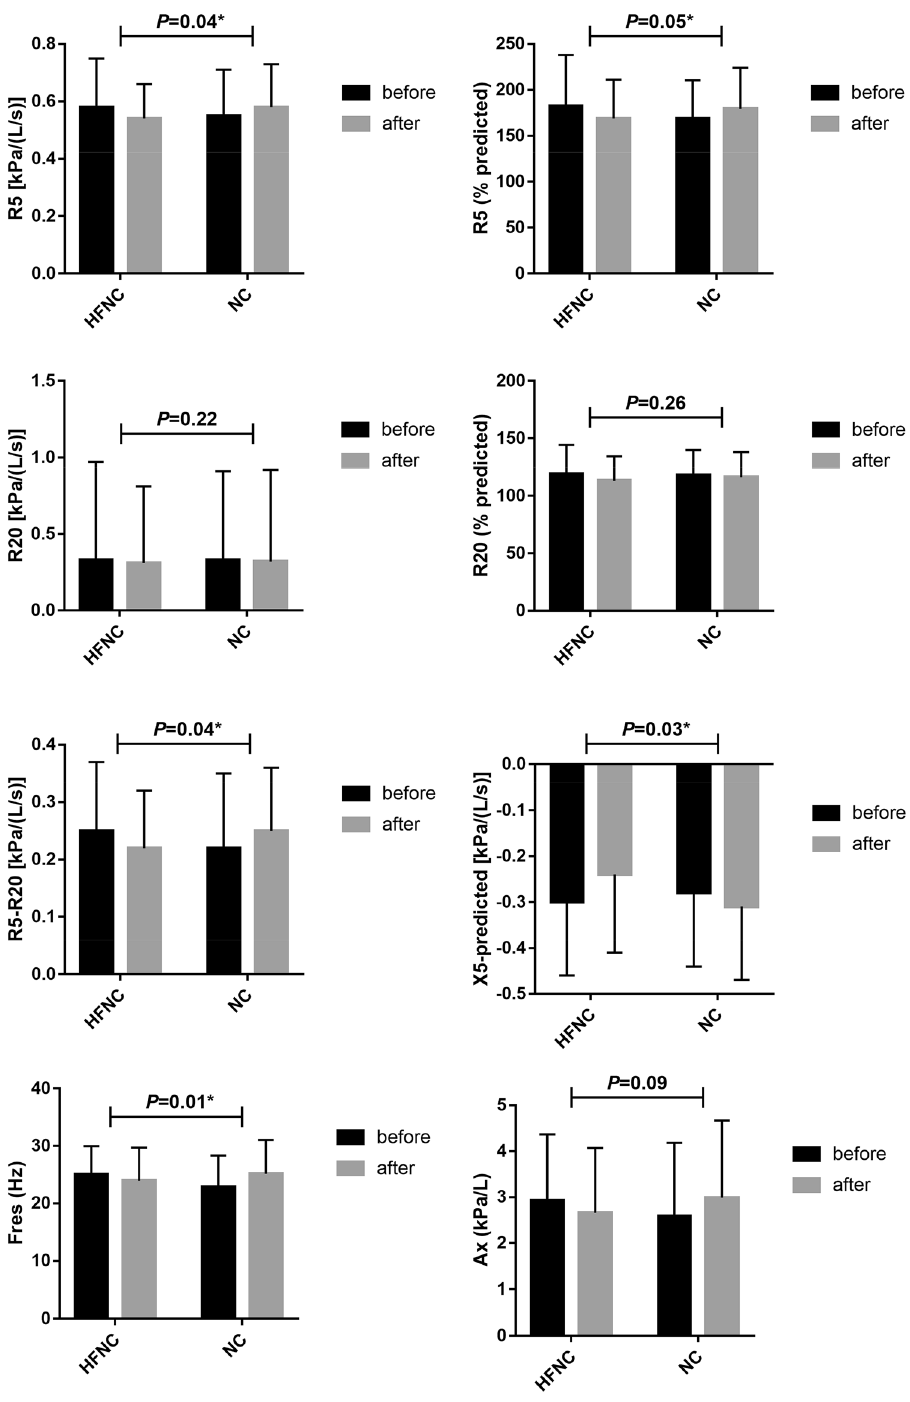
Figure 2. The high-flow nasal cannula (HFNC) intervention reduced total airway resistance, small airway resistance, and reactance in patients with stable COPD. The HFNC intervention decreased resistance (R)5 (kPa/ [L/s]) ( p = 0.04), R5 (% predicted) ( p = 0.05), R5–R20 (kPa/[L/s]) ( p = 0.04), X5-predicted (kPa/[L/s]) ( p = 0.03), and Fres (Hz) ( p = 0.01), indicating that HFNC improves small airway resistance and peripheral lung